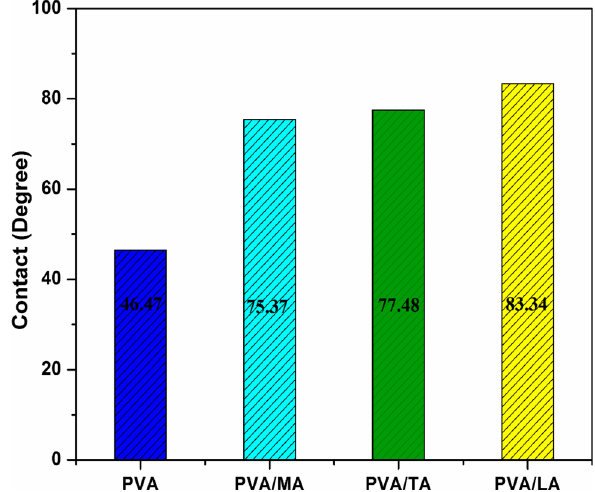
Fig. 8 Contact angles for a PVA, b PVA/MA, c PVA/TA, and d PVA/ LA